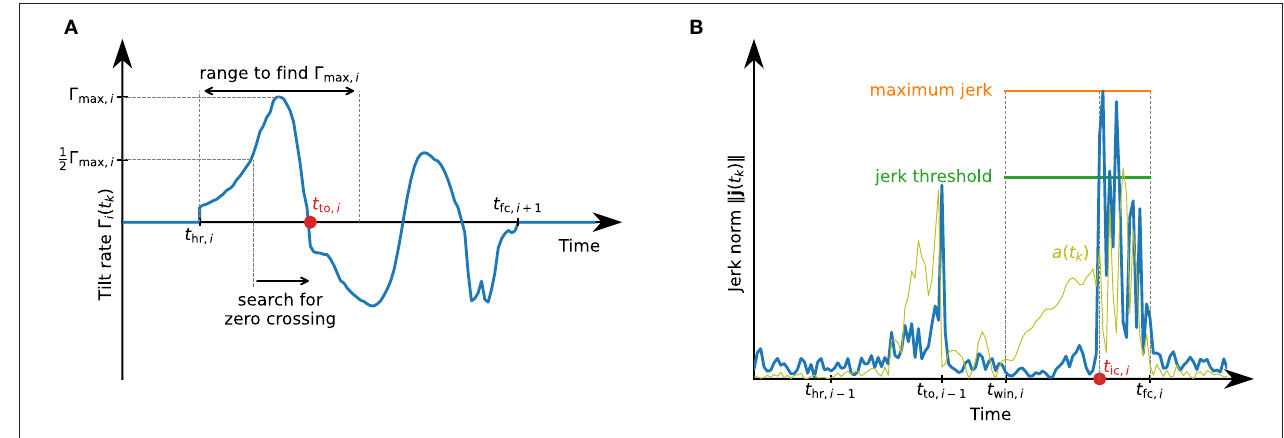
FIGURE 7 | Detection of toe-off and initial contact events that define the swing phase. (A) Illustration of the toe-off detection. Between heel rise and full contact, the tilt rate might exhibit multiple local maxima and zero-crossings. For a robust detection of the correct zero-crossing, we first find the maximum value during the first half of the phase from t hr, i to t fc, i + 1 and search for the first zero-crossing after the tilt rate has reached half of this maximum. (B) Illustration of the initial contact detection based on the jerk norm. Note how the jerk norm reflects the sudden change when the foot touches the ground much better than the accelerometer norm signal a ( t k